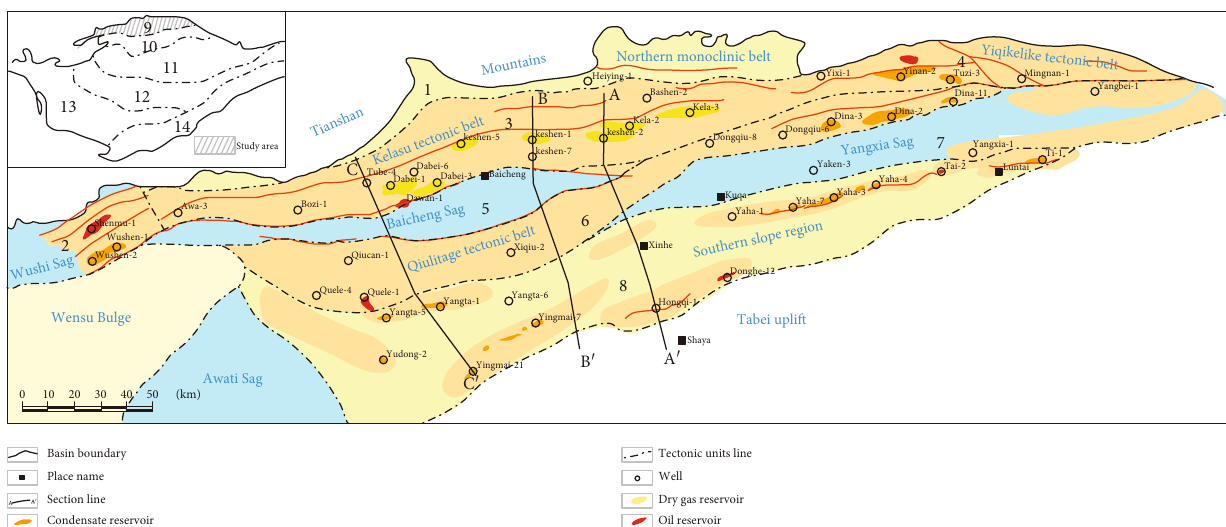
Figure 1: Sketch map of the Kuqa foreland basin (modi fi ed from Lu et al., 2018): (1) North monocline zone; (2). Wushi Sag; (3) Kelasu structural belt; (4) Yiqikelike structural belt; (5) Baicheng Sag; (6) Qiulitage structural belt; (7) Yangxia Sag; (8) South slope belt; (9) Kuqa depression; (10) Tabei uplift; (11) Northern depression; (12) the central uplift; (13) Southwest depression; (14) Tadong